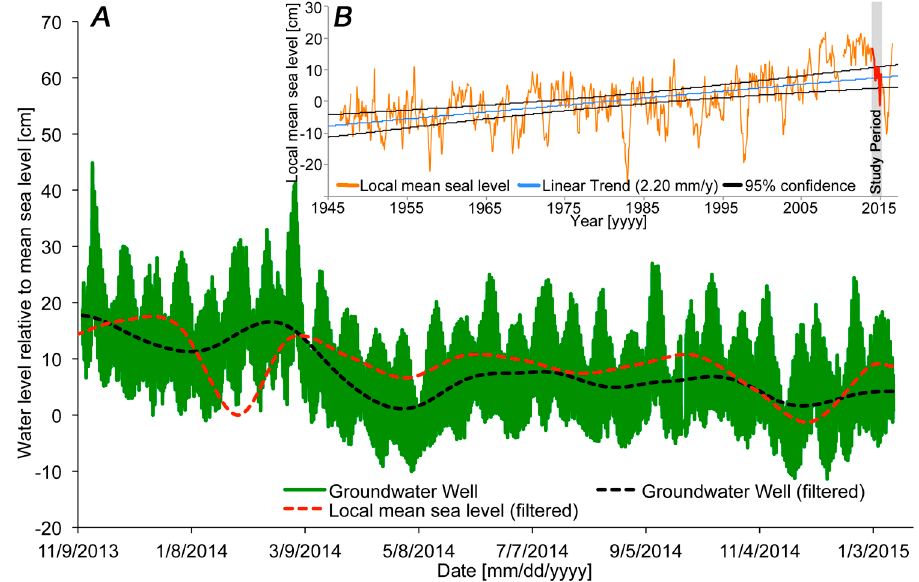
Figure 10. Time series of sea-level forcing and well response; ( A ) Comparison of groundwater levels and sea levels during the study at Well R11; ( B ) Local mean sea-level curve from 1945 to 2017. Period pertaining to this study is marked in gray. Sea level data for Kwajalein Atoll from NOAA [52]. A Butterworth filter with a frequency cutoff of 60 d was used to filter data.